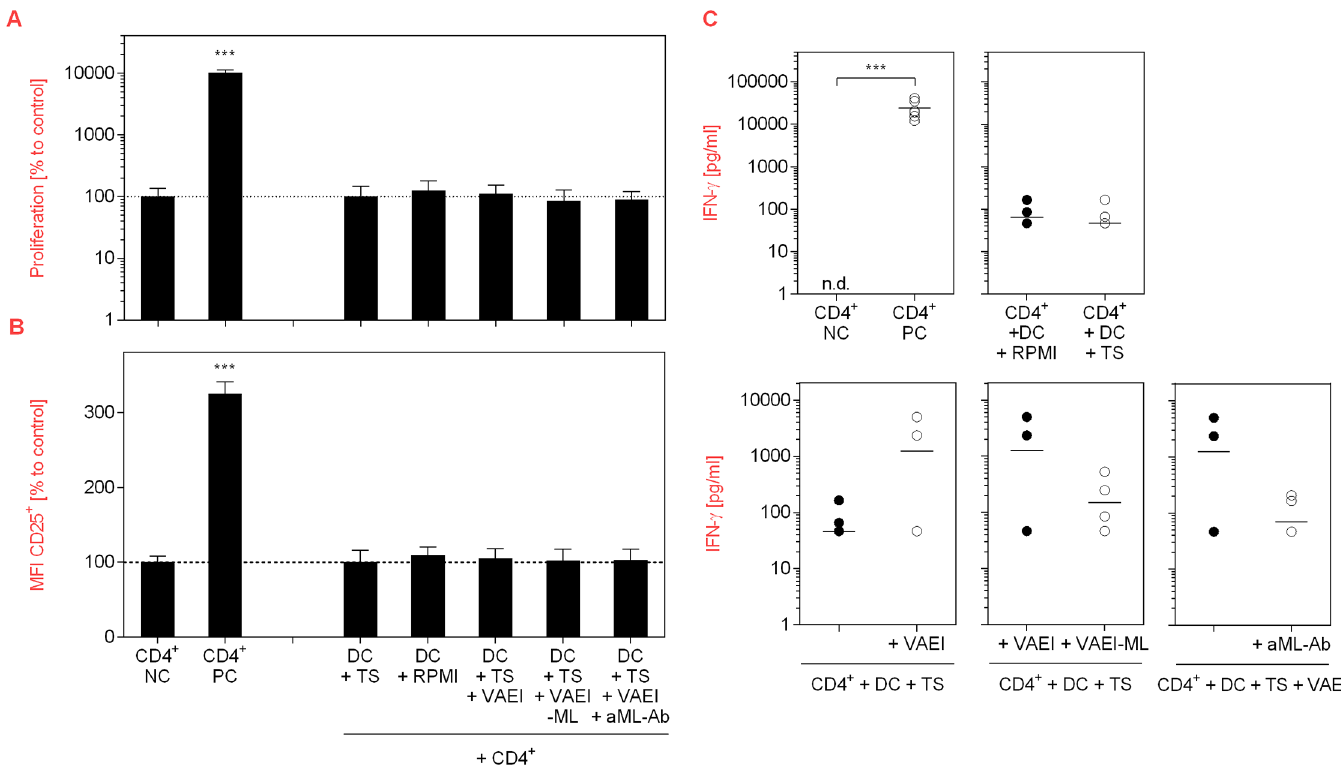
Fig 9. Effects of VAEI-treated DC on T cells after tumor-induced immunosuppression. Purified humanCD4 + T lymphocyteswere culturedin the presenceof medium (NC) or stimulatedwith phytohemagglutinin-L(PC; 10 μ g/ml). Co-cultivation of T cells was carried out with unstimulated DC treated with 10% RPMI 1640 medium (CD4 + + DC + Medium), 10% tumor supernatant of an RCC line (CD4 + + DC + TS + ), TS and VAEI (CD4 + + DC + TS + VAEI; Iscador ® Qu Spez; 0.5 μ g/ml), TS and ML-depletedVAEI (CD4 + + DC + TS + VAEI-ML; Iscador ® ;0.66 μ g/ml) or TS, VAEI and anti-ML antibody (CD4 + + DC + TS + VAEI + aML-Ab, CD4 + ; 2.5 μ g/ml). (A) Cell division analysiswas doneusing CFSE staining and flow cytometry. (B) CD25 surface marker expression was analyzedas a second indicatorfor T cell activation.Data from 6 individualexperiments are presented as mean ± SD in relationto untreatedT cells (NC) or T cells co-cultured with TS-treated DC (DC + TS). (C) IFN- γ release by T cells was analyzedin the supernatants of 6 independentco-culture experiments using cytokine bead array assay. Asterisks indicatesignificant differences betweenthe groups ( * P < 0.05, ** P < 0.01, *** P < 0.001). Data points with values belowthe detectionlimit are not